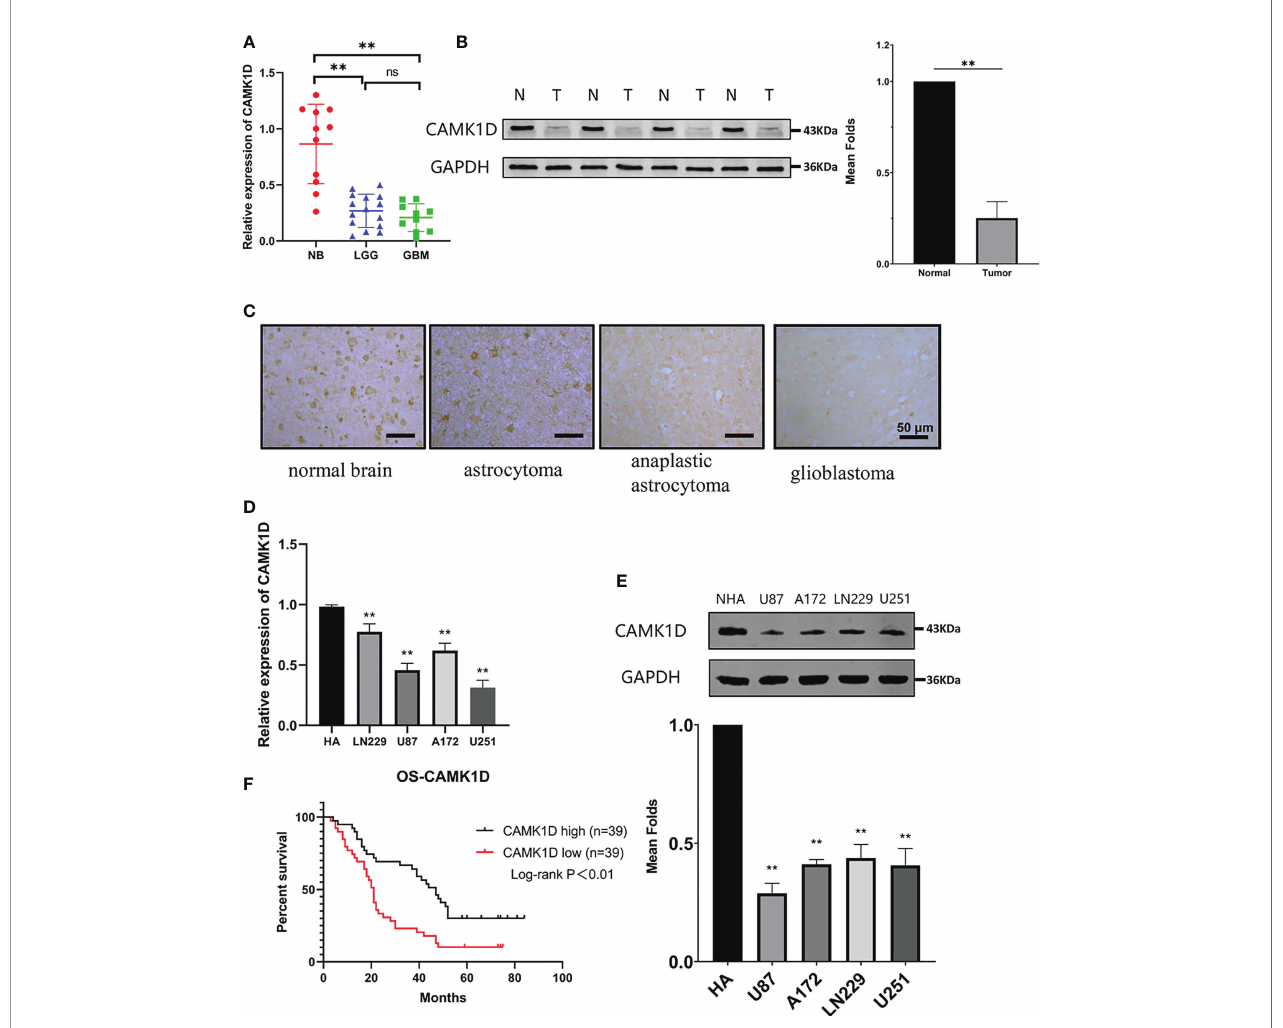
FIGURE 3 | CAMK1D expression in tissues and cells. (A) CAMK1D mRNA expression was sign fi cantly decreased in glioma samples compared with normal brain samples (NB = 11; LGG = 15; GBM = 10). (B) CAMK1D protein expression was signi fi cantly decreased in four glioma samples compared with four normal brain samples with Western blot analysis. (C) Immunohistochemistry showed that the expression of CAMK1D immunoreactivities were different in normal brain tissue, astrocytoma, anaplastic astrocytoma, and glioblastoma. (D, E) CAMK1D expression levels in HA cell lines and four glioma cell lines were determiend by RT-PCR and Western blot. Both mRNA and protein levels were sign fi cantly decreased in the 4 glioma cell lines compared with HA cell lines. (F) Kaplan – Meier curves for overall survival of glioma patients based on expression of CAMK1D protein (78 glioma samples) showing that low-level CAMK1D expression was closely associated with the poor overall survival of glioma patients. ns, no signi fi cance; ** p <